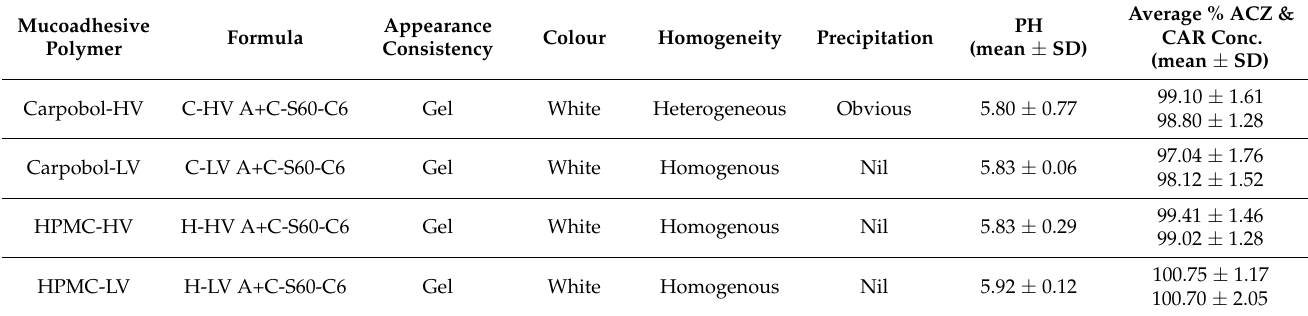
Table 5. Physical properties and PH values of freshly prepared niosomes gel formulations